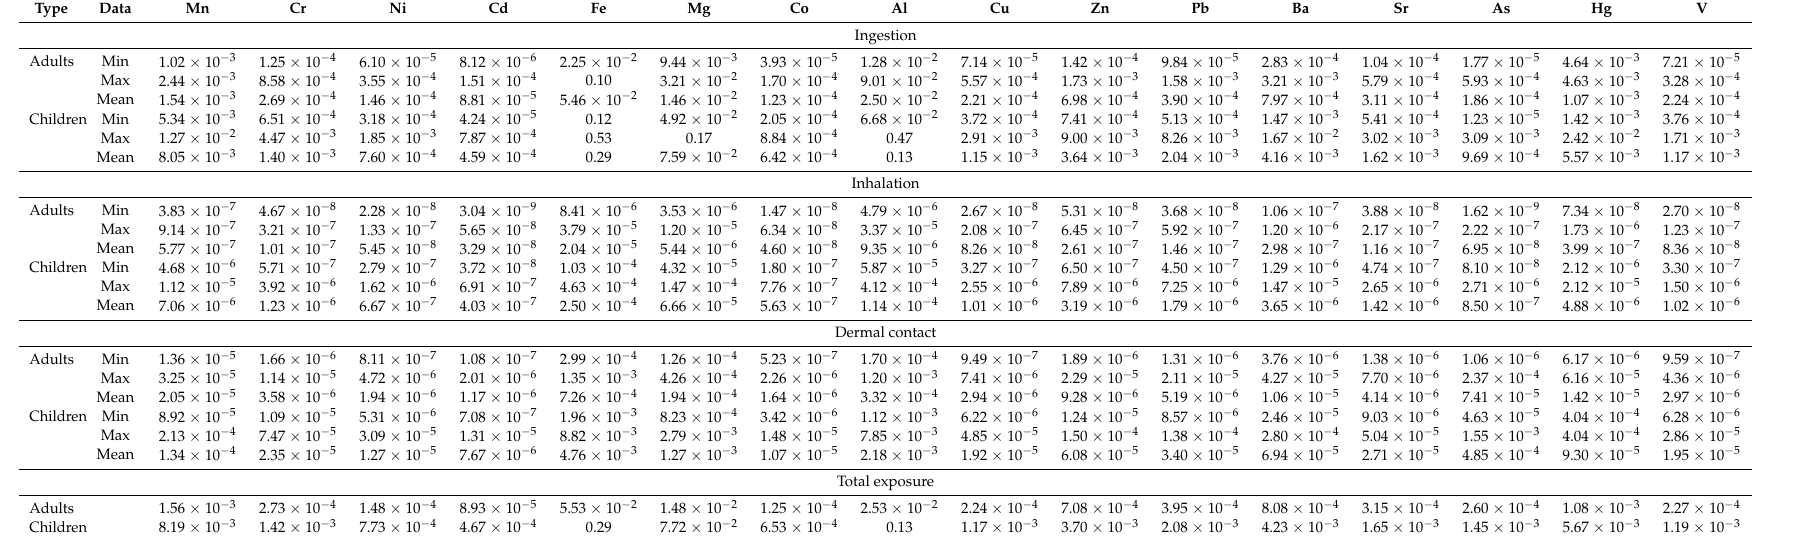
Table 5. Average daily exposure dose for non-carcinogenic elements through ingestion, inhalation and dermal contact.